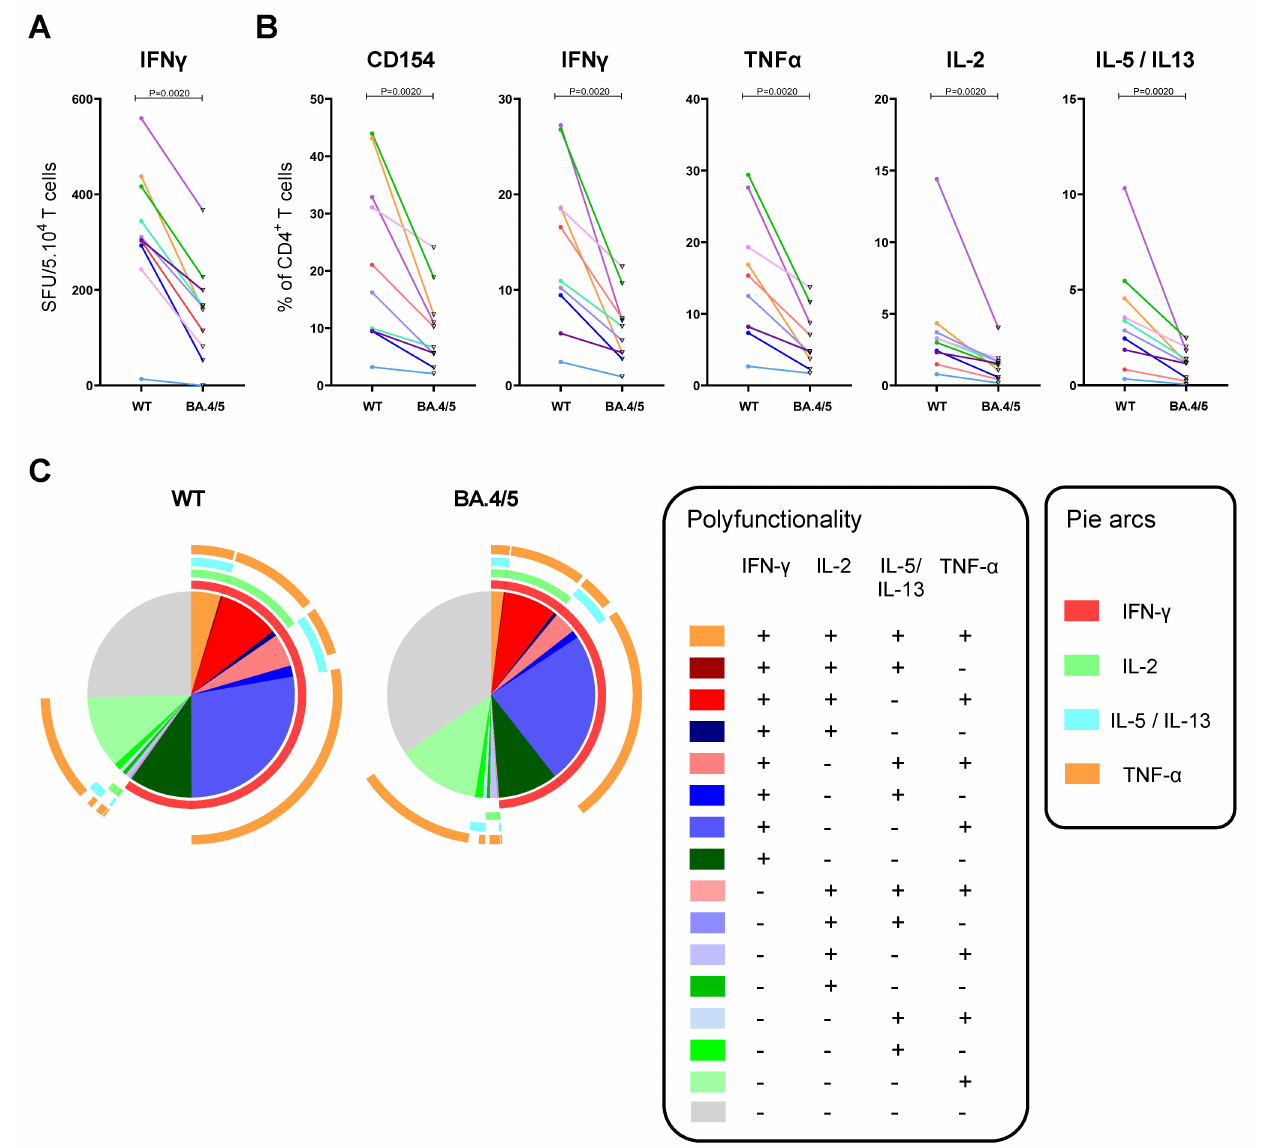
Figure 2. Functional impact of various Omicron BA.4/BA.5 mutations on cross-reactivity to spike of the T cell lines obtained from vacinees. Polyclonal spike-enriched T cell lines were restimulated with “WT CD4+ pool”(WT) or “Omicron BA.4/BA.5 CD4 + pool” (BA.4/5), and cultures were analyzed for ( A ) IFN- γ producing spot-forming cells (SFU) per 5 × 10 4 T cells as quantified by an IFN- G ELISPOT assay (after 24 h restimulation); and for ( B ) percentage of CD154 marker expression, and intracellular IFN- G , TNF- α , IL-2 and IL-5/IL-13 expression of CD4 + T cells, as indicated, by flow cytometry (after 6 h restimulation). Responses of each subject are presented by pairs of symbols (closed colored dots for WT restimulation versus open triangles with black border for BA.4/5 restimulation) connected with a colored line per subject. p values less than 0.05 were considered statistically significant. ( C ) Pie charts show the proportion of activated CD145 + /CD4 + T cells (median values) secreting no, one, or multiple cytokines upon WT or BA.4/5 stimulation, as